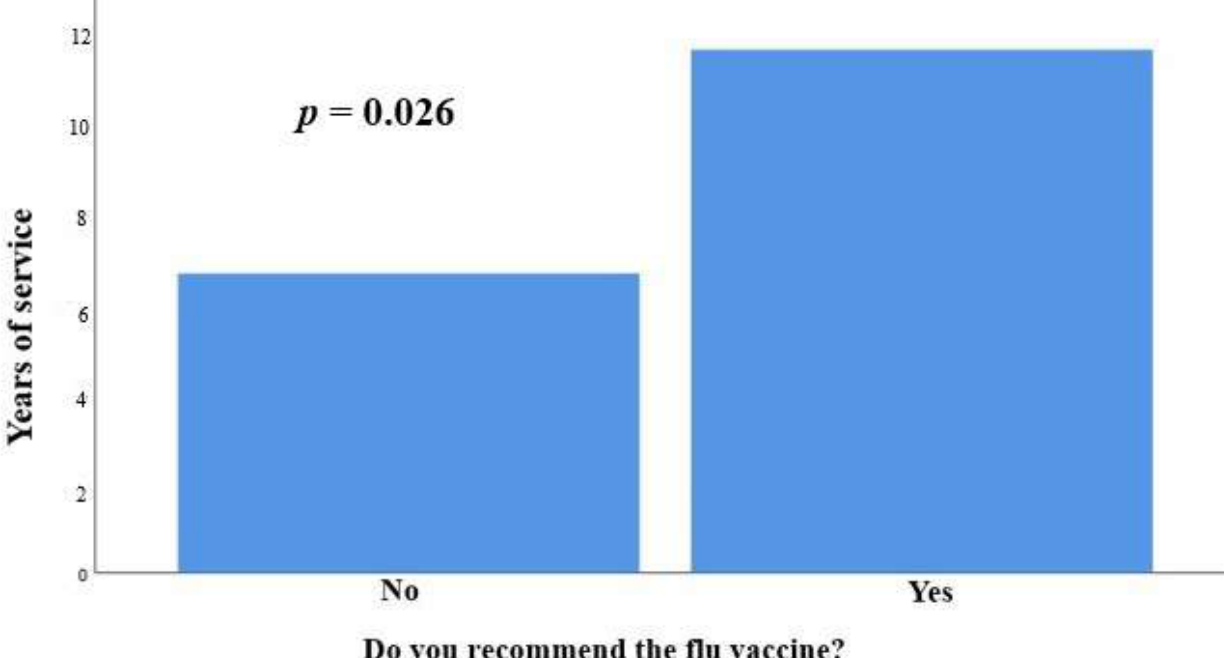
Figure 3. The participants who recommended the flu vaccine had greater work experience (11.73 ± 8.54 years vs. 6.71 ± 5.79 years, p =